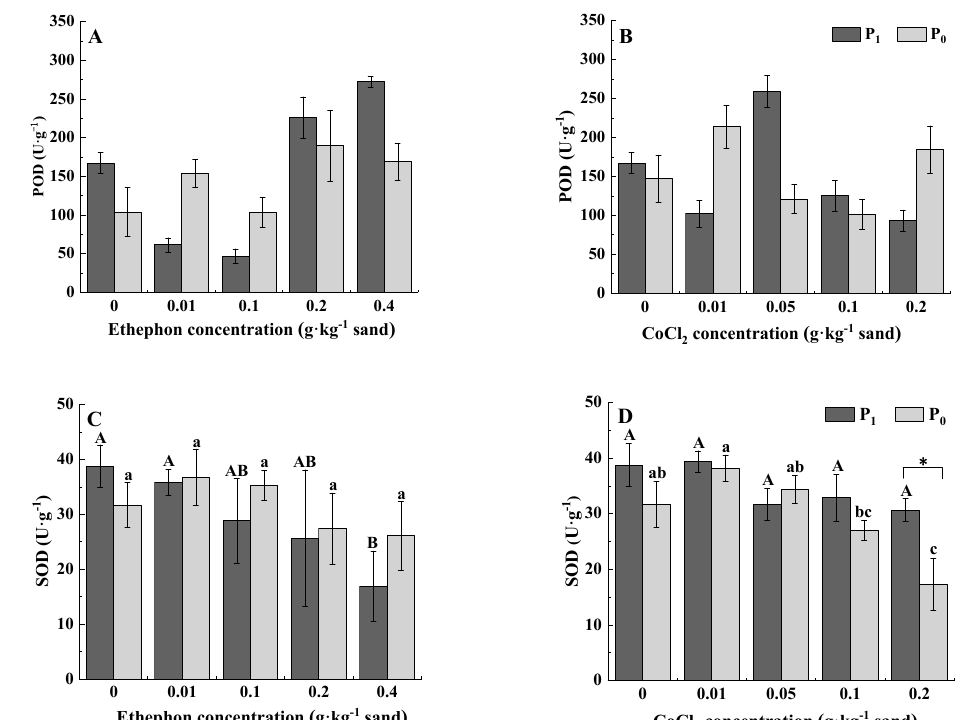
Figure 3. Differences in the POD activity ( A , B ) and SOD activity ( C , D ) between the two groups, namely phosphorus supply (1 mmol · KH 2 PO 4 , P 1 ) and no phosphorus supply (0 mmol · KH 2 PO 4 , P 0 ), treated with different concentrations of exogenous additives (ethephon and CoCl 2 ). Bars (mean ± standard error) accompanied by the same lowercase letter(s) are not significantly different at the 5% probability level. Different capital letters indicate significant differences between different additive concentrations under normal P supply conditions, while different lowercase letters indicate significant differences between different additive concentrations under low-P stress. * Indicates that the same additive concentration is significantly different under different P supply